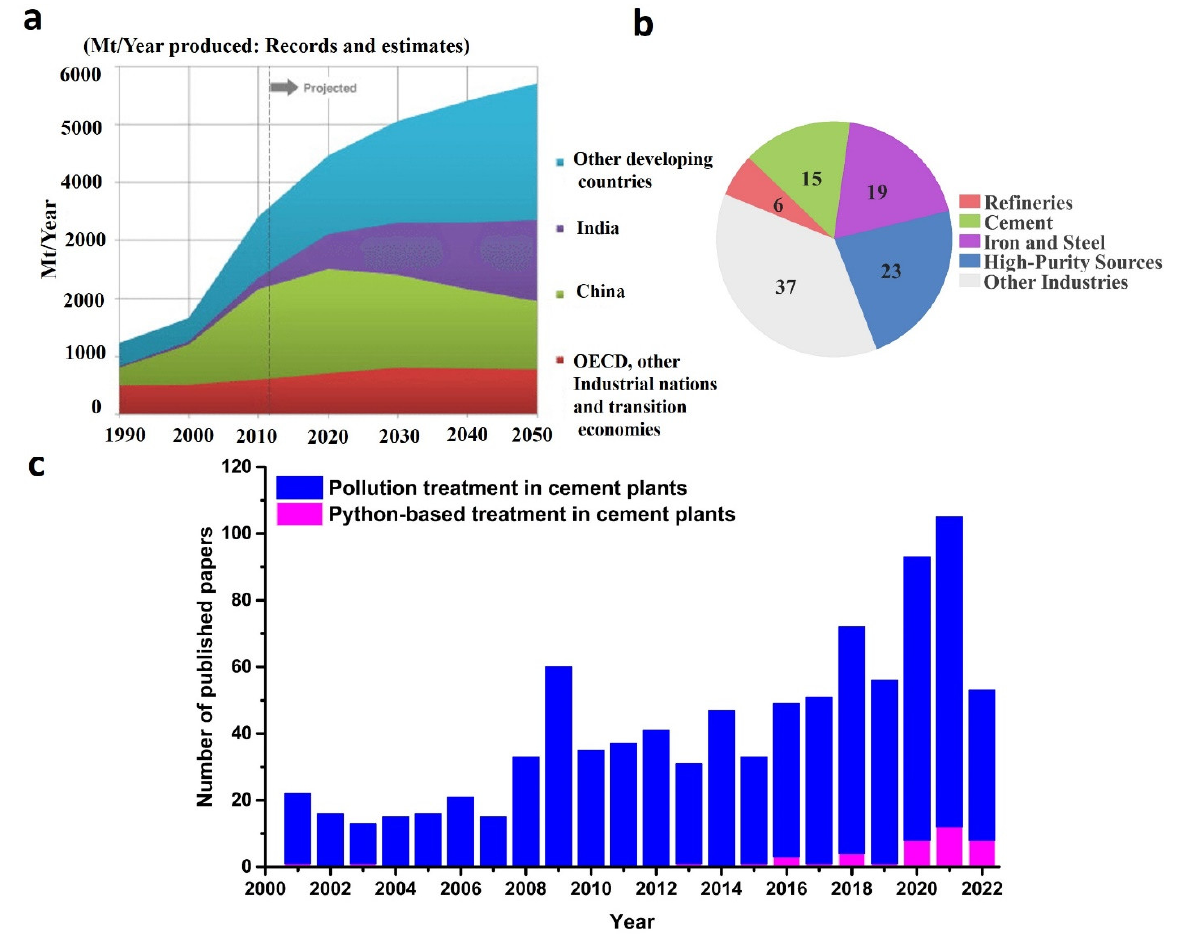
Figure 1. ( a ) Production of cement from 1990 up until now and the predicting the cement manufac- turing up to 2050 (reprinted under open access license from Ref. [12]), ( b ) the emitted CO 2 pollution from various industries, ( c ) the number of Scopus-indexed papers regarding the pollution-treatment in the cement industries, and the number of Scopus-indexed published research to treat pollution in the cement industries using Python.